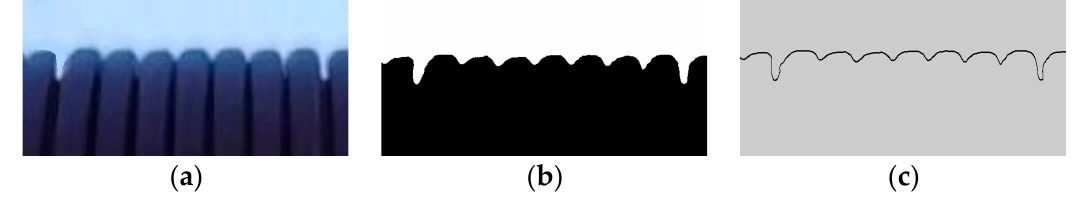
Figure 12. ROI image of contour: ( a ) coil image, ( b ) binary image, ( c ) edge image.